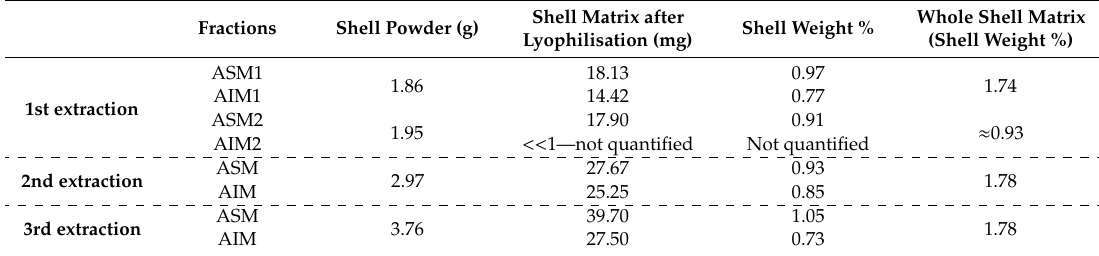
Table 1. Quantity of shell matrices (soluble and insoluble) extracted from the shell of A. hians . The first extraction was performed after one and two bleaching treatments, while the second and the third extractions were done after one bleaching treatment. ASM: acid soluble matrix; AIM: acid insoluble